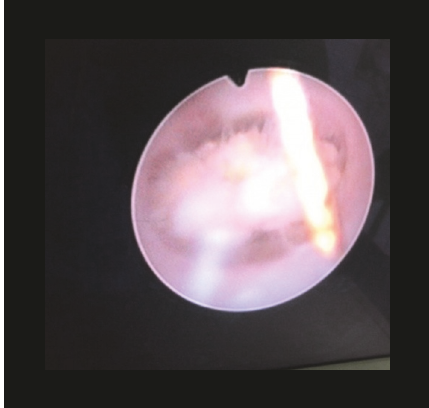
Figure 5: Endoscopic view of the calculus (case